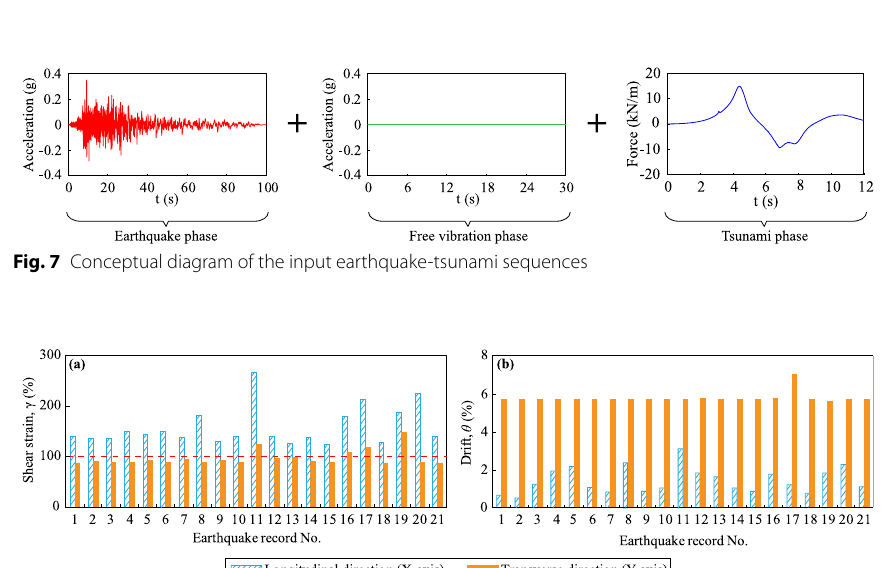
9 m: a bearing and b